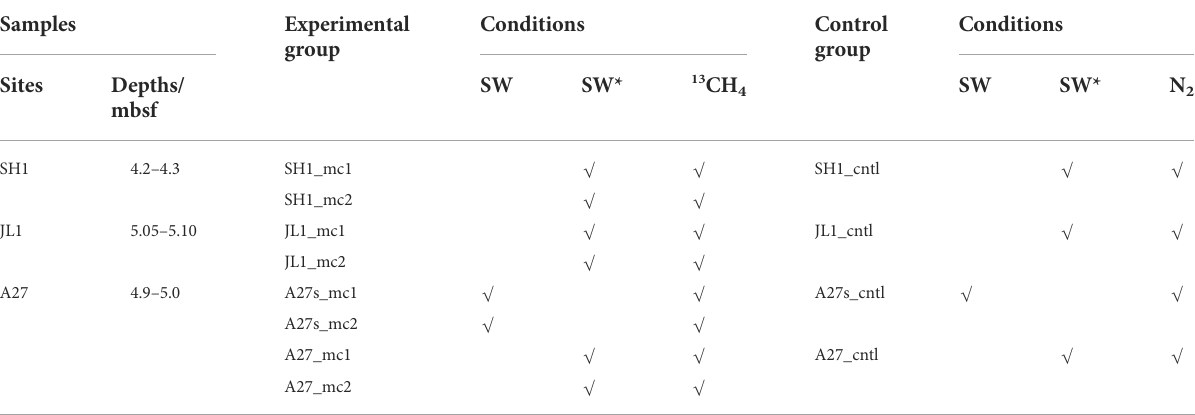
TABLE 1 Conditions and serial number of each incubation